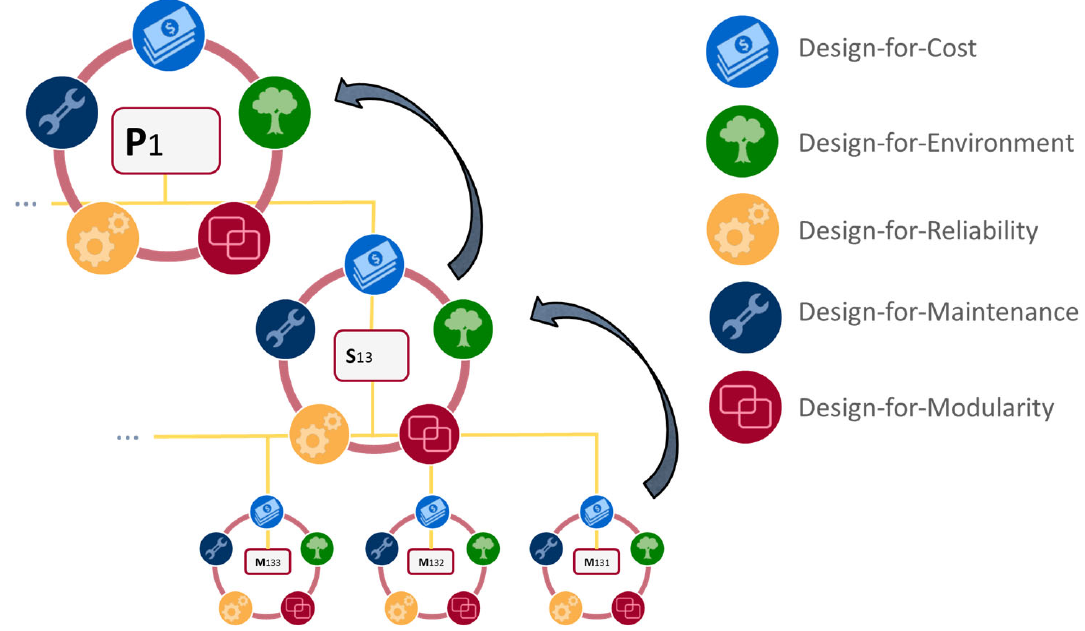
Figure 7. Bottom-up aggregation of efficiency and effectiveness values (modules, system and product) Figure 7. Bottom ‐ up aggregation of efficiency and effectiveness values (modules, system and prod ‐ uct) [2].